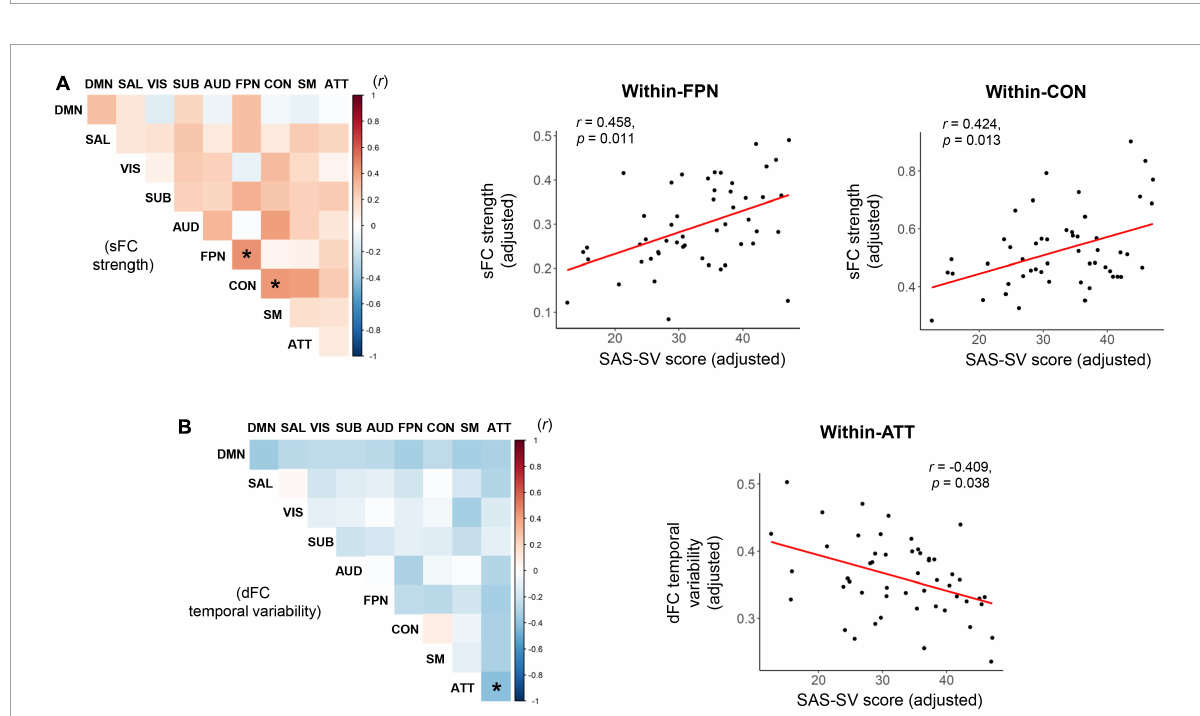
FIGURE4 Results of partial correlations between the short version of the smartphone addiction scale (SAS-SC) score and the within-or between-subnetwork static functional connectivity (sFC) strength (A) and dynamic functional connectivity (dFC) temporal variability (B) . The scatter plots for the significant correlations were also presented on the right side. ATT, attention subnetwork; AUD, auditory subnetwork; CON, cinguloopercular subnetwork; DMN, default-mode subnetwork; FPN, frontoparietal subnetwork; SAL, salience subnetwork; SM, sensorimotor subnetwork; SUB, subcortical subnetwork; VIS, visual subnetwork. *Indicates a significant correlation with corrected p <